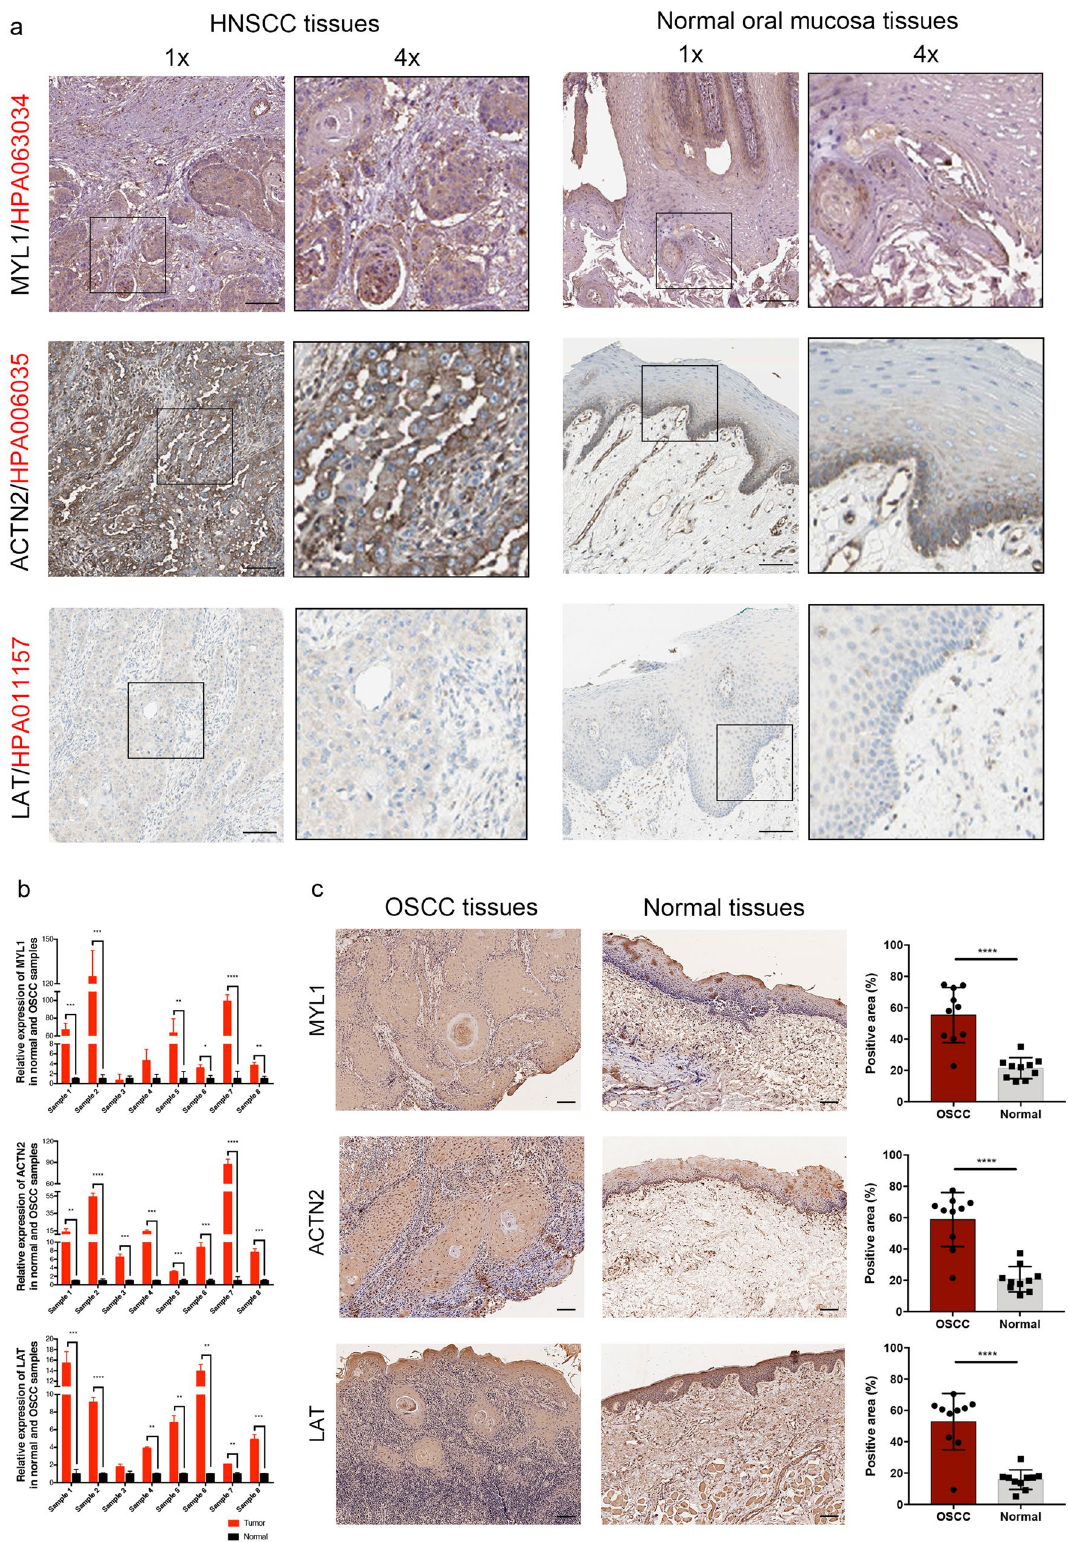
Figure 8. MYL1, ACTN2 and LAT expression validation. ( a ) Protein expression levels in HNSCC as compared to those in normal tissues by IHC staining from the Human Protein Atlas database. Black square boxes represent typical normal and HNSCC tissues, respectively. ( b ) Comparison of gene expression level by using qPCR. ( c ) IHC staining of the proteins in OSCC tissues and normal oral mucosa tissues. Scale bars represent 100 µm. *: P < 0.05; **: P < 0.01; ***: P < 0.001; ****: P <